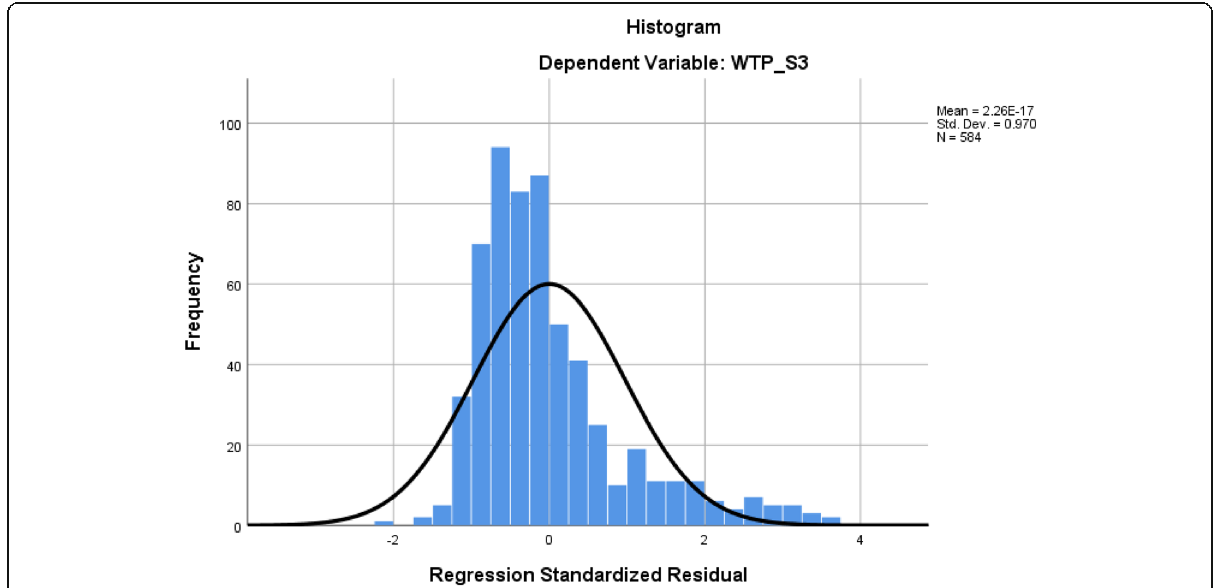
Fig. 11 Histogram of the residuals of regression of Model C (explanatory variables against WTP for AB)